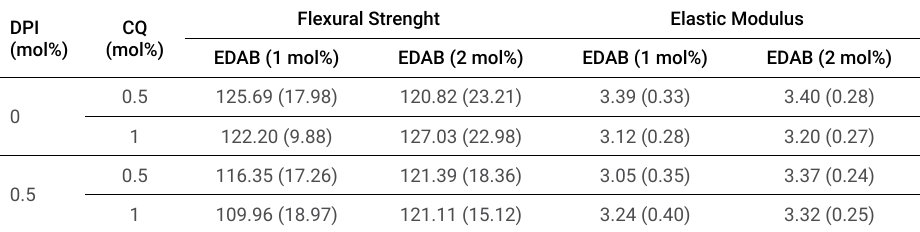
Values followed by the different upper case letter in the same column or by different lower case letter in the same row are statistically different ( p < 0.05). * and # represents statistical difference for DPI.